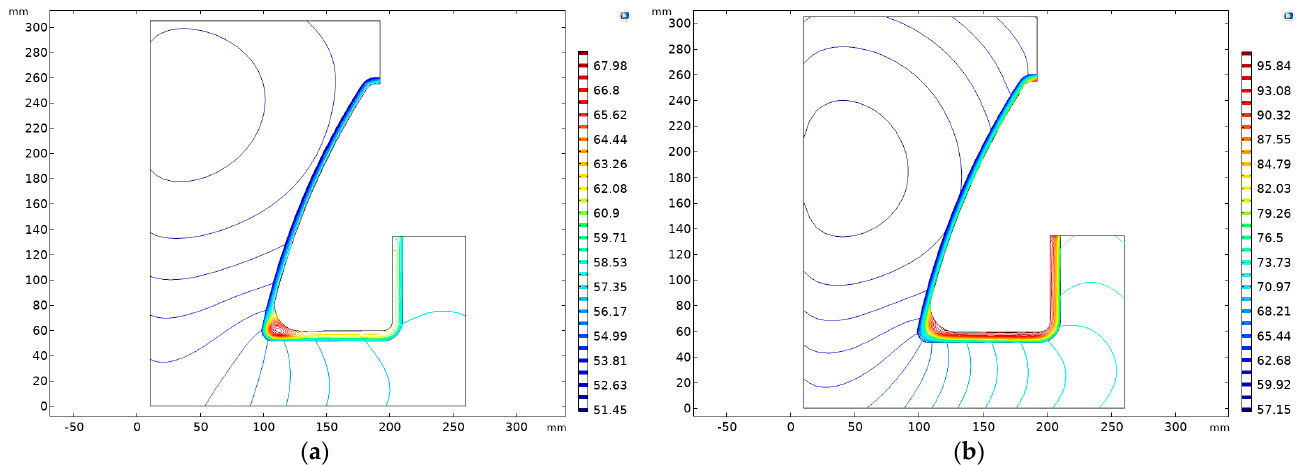
Figure 12. Isothermal curves for α = 0.95: ( a ) Tmax 60 °C and ( b ) Tmax 100 °C.